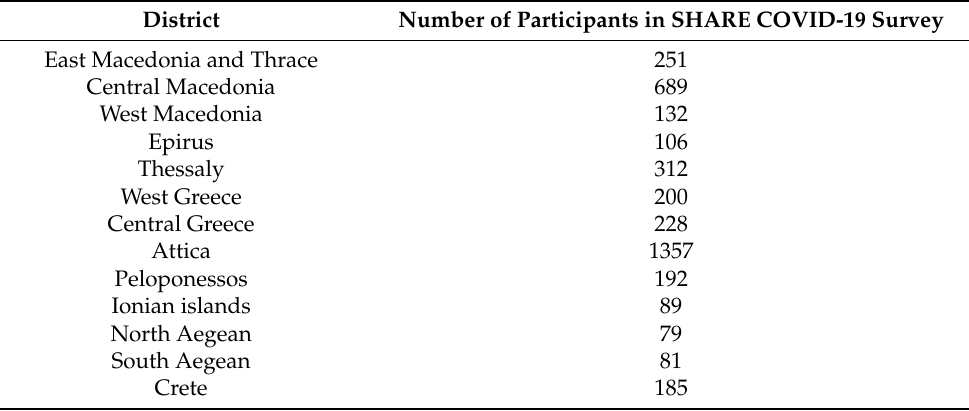
Table A2. Age distribution of SHARE COVID-19 survey in Greece.